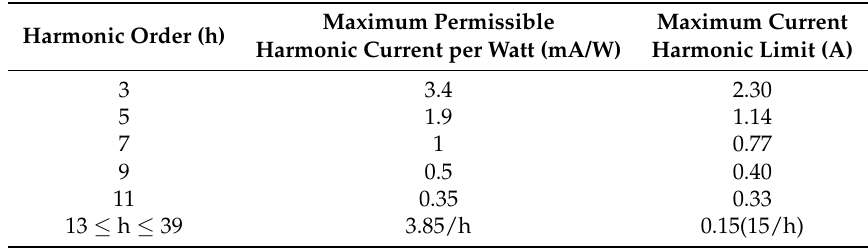
Table 2. Current harmonic limits for class D